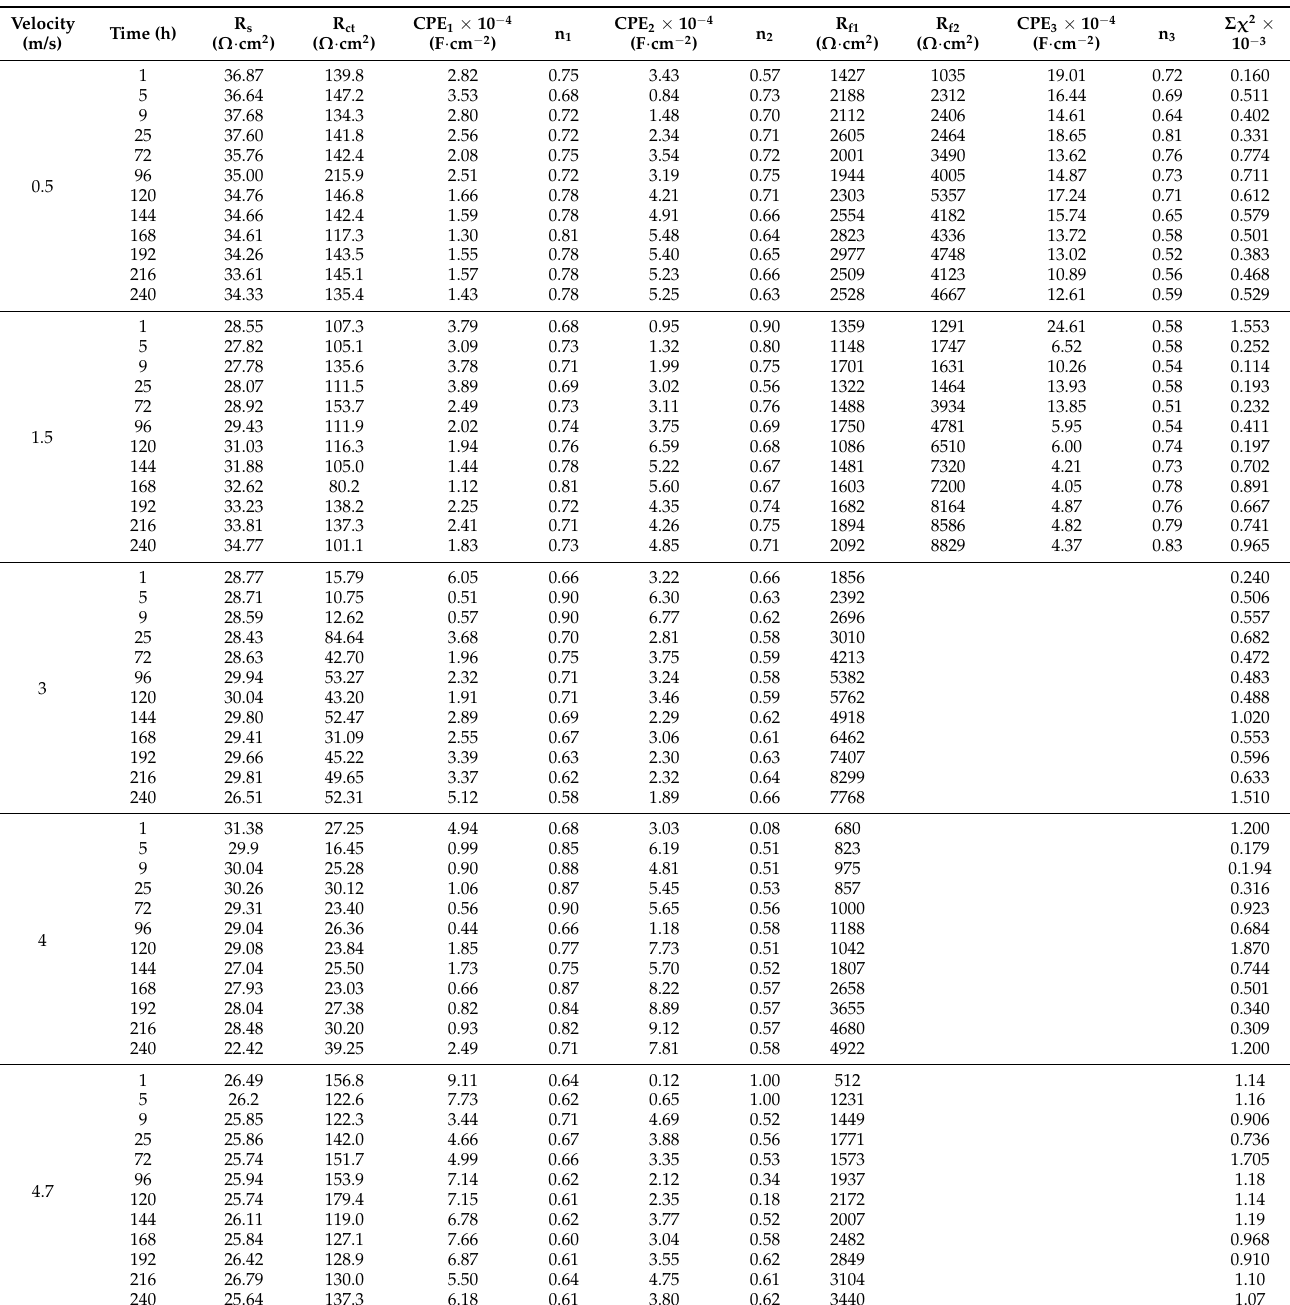
Table 2. Electrochemical parameters of 90/10 copper–nickel samples obtained by fitting EIS